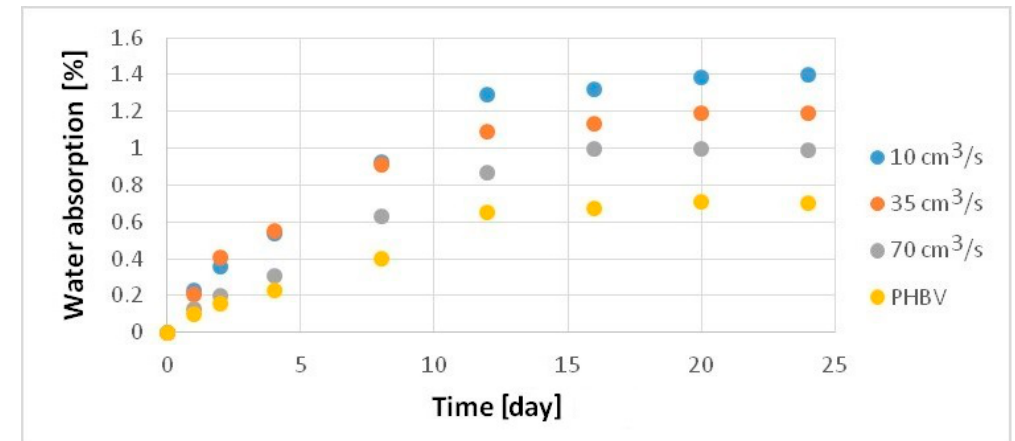
Figure 9. Water absorption of samples produced at a variable injection rate compared to a pure PHBV sample produced at 35 cm 3 /s.